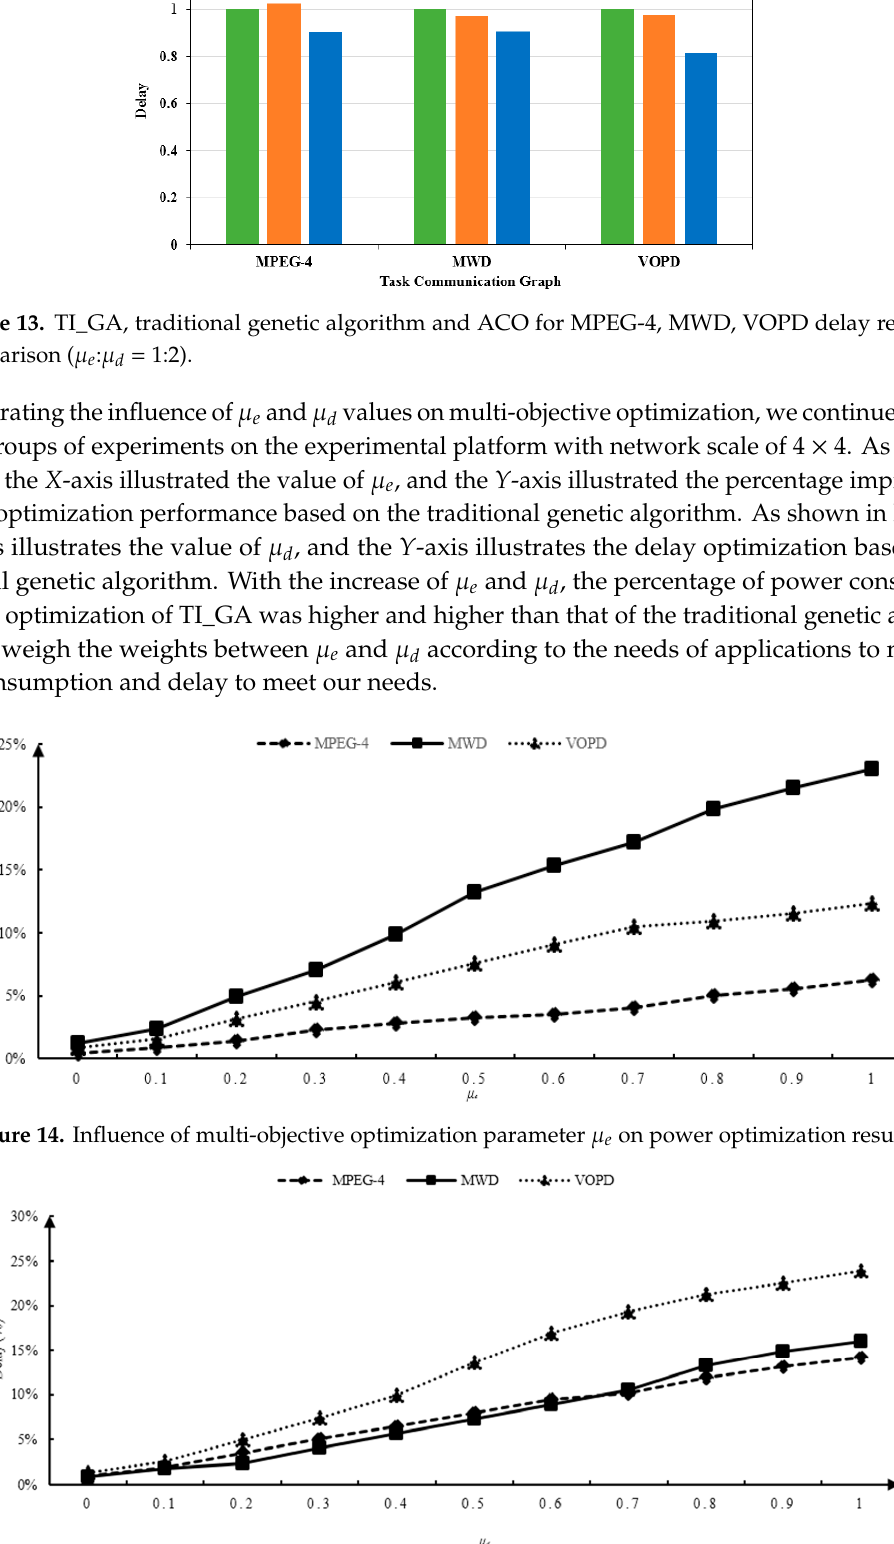
Figure 12. TI_GA, traditional genetic algorithm and ACO for MPEG-4, MWD, VOPD power results comparison ( μ e : μ d = 1:2).